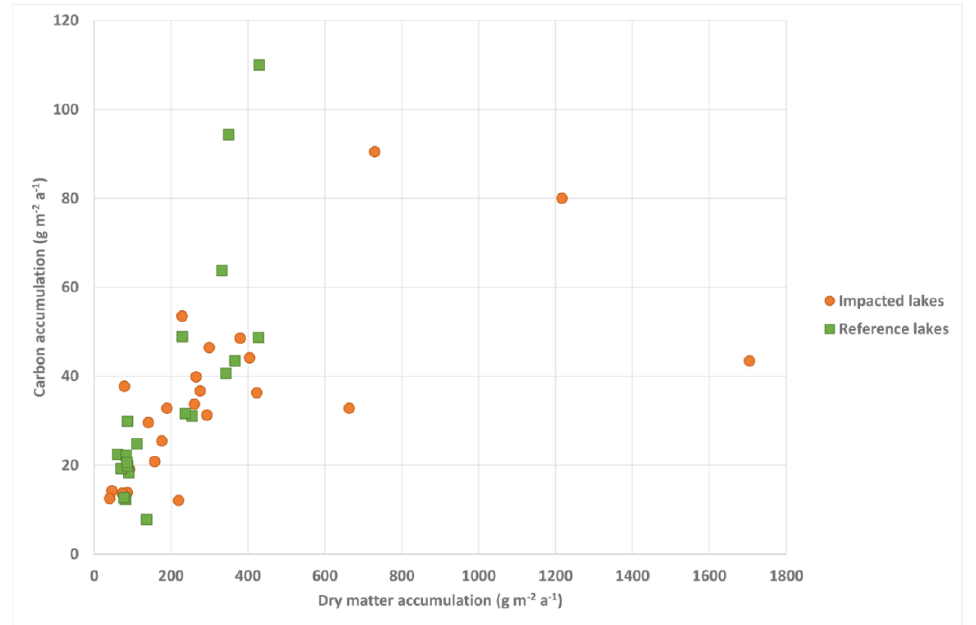
Figure 7. Annual average carbon and dry matter accumulation rates for the post-1986 period in the impacted and reference lakes. impacted and reference